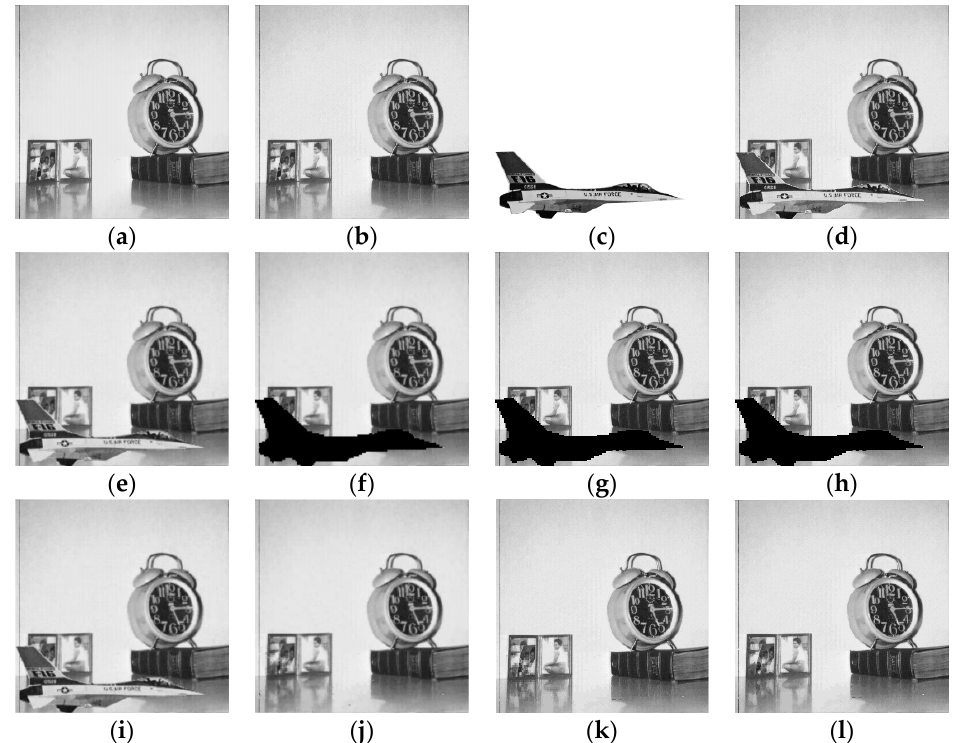
Figure 12. Tamper detection and recovery results of a content-only attack on the Clock image: ( a ) original image; ( b ) watermarked image; ( c ) tamper reference; ( d ) tampered image; ( e ) tamper detection result of [8]; ( f ) tamper detection result of [9]; ( g ) tamper detection result of [7]; ( h ) tamper detection